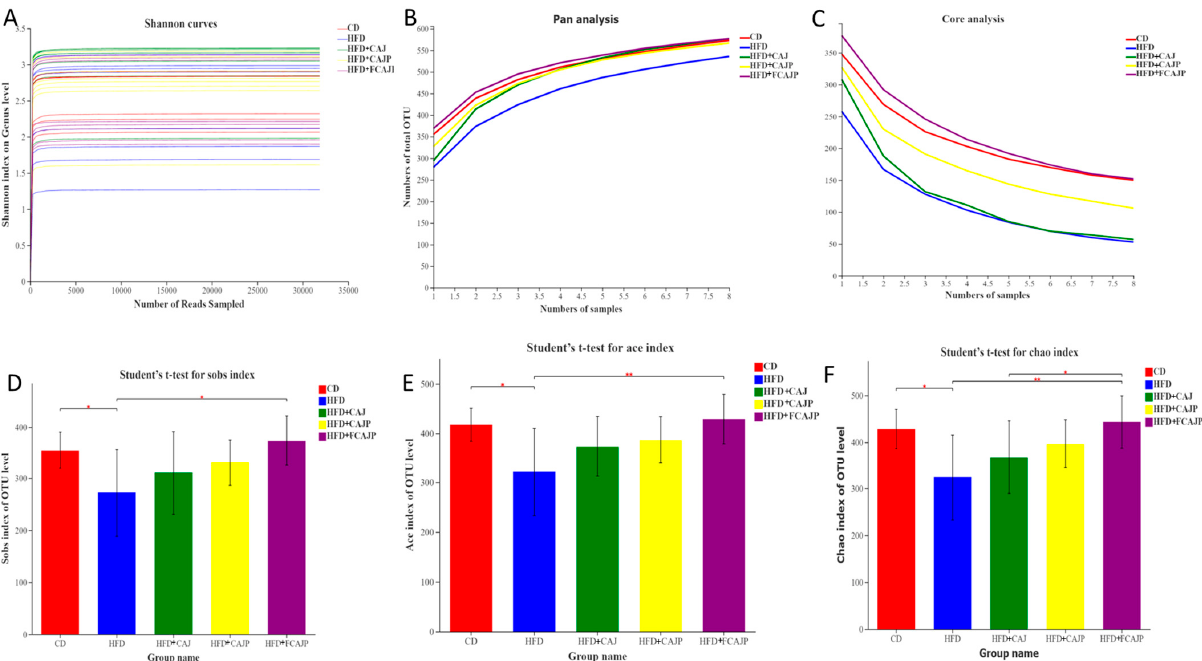
Figure 3. Responses of the diversity, richness, and structure of the gut microbiota ( n = 8). ( A ) Shannon curves; ( B ) Pan analysis; ( C ) Core analysis; ( D ) Comparisons between Sobs indexes of five groups; ( E ) Comparisons between Ace indexes of five groups; ( F ) Comparisons between Chao indexes of five groups. Note: CD: basal diet & Saline; HFD: 45% high-fat diet & Saline; HFD + CAJ: 45% high-fat diet & CAJ; HFD + CAJP: 45% high-fat diet & CAJP; HFD + FCAJP: 45% high-fat diet &FCAJP. Differences were assessed by student’t t -test and denoted as follows: * p < 0.05 and ** p < 0.01 in a comparison between the two groups. Values are presented as mean ± SEM.